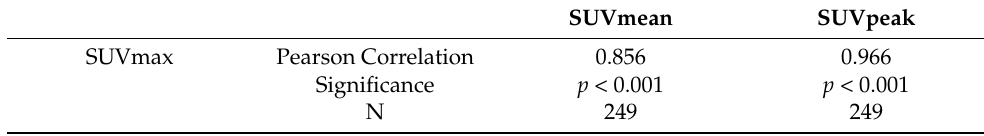
Table 5. SUVmax and SUVmean correlation coefficient and statistical